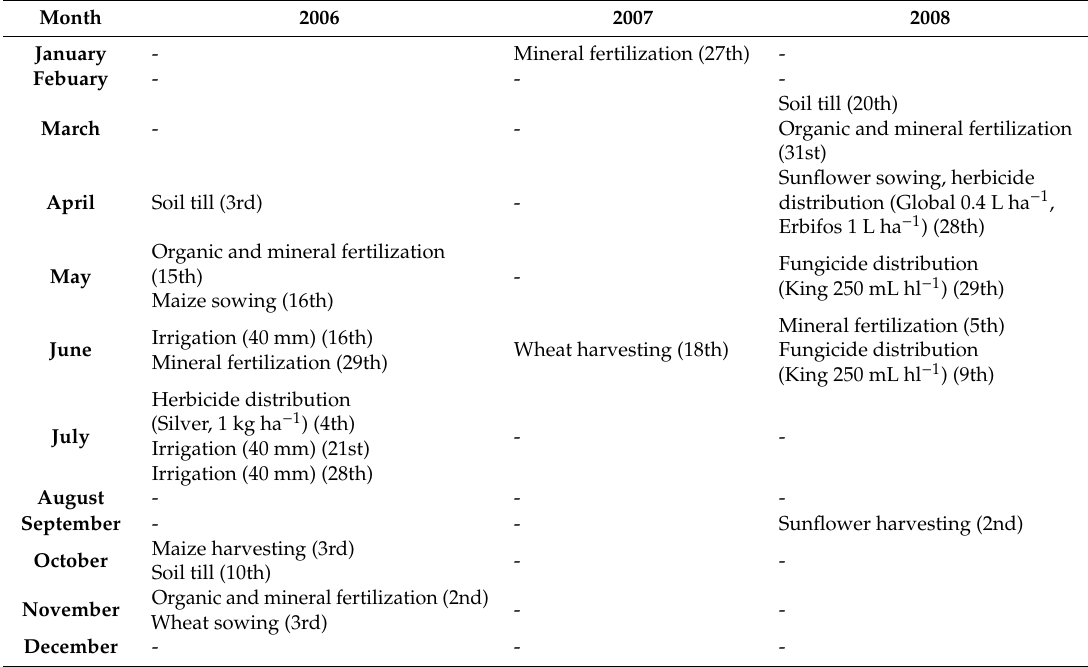
Table 2. Main agronomic operations carried out during the three-year crop succession.